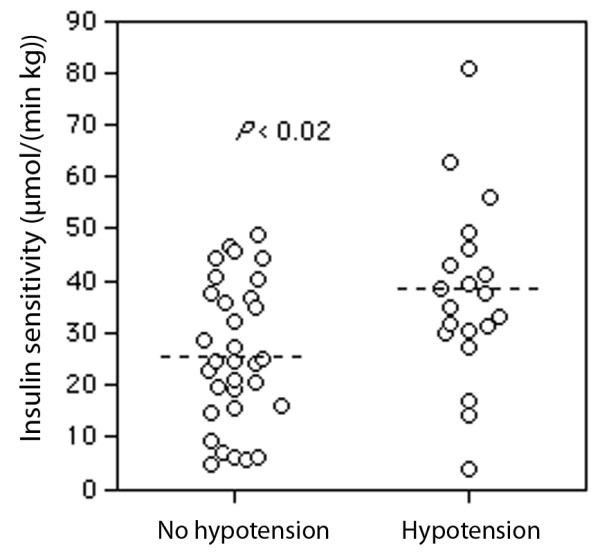
The incidence of arterial hypotension in the postoperative ward (systolic blood pressure < 80 mmHg). Low insulin sensitivity implies high insulin resistance. Each point represents one patient. The dashed lines indicate median values.